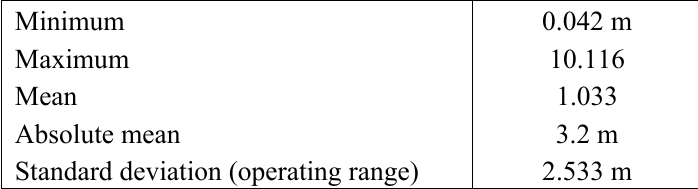
Table 2. Statistics of the residual displacements btw. the GPS reference trajectory and that estimated by the particle filter shown in Figure